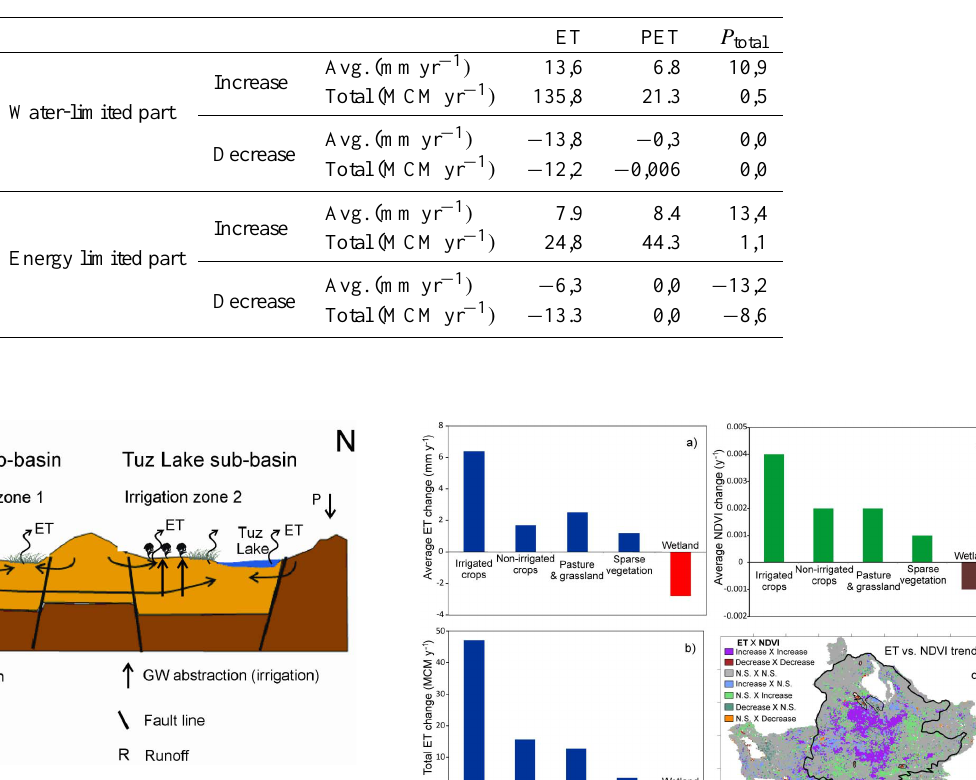
Table 2. The quantitative summary of ET, PET and P trends for the areas with significant ET trend ( p < 0 . 25) in the energy- and water- limited parts, separately.